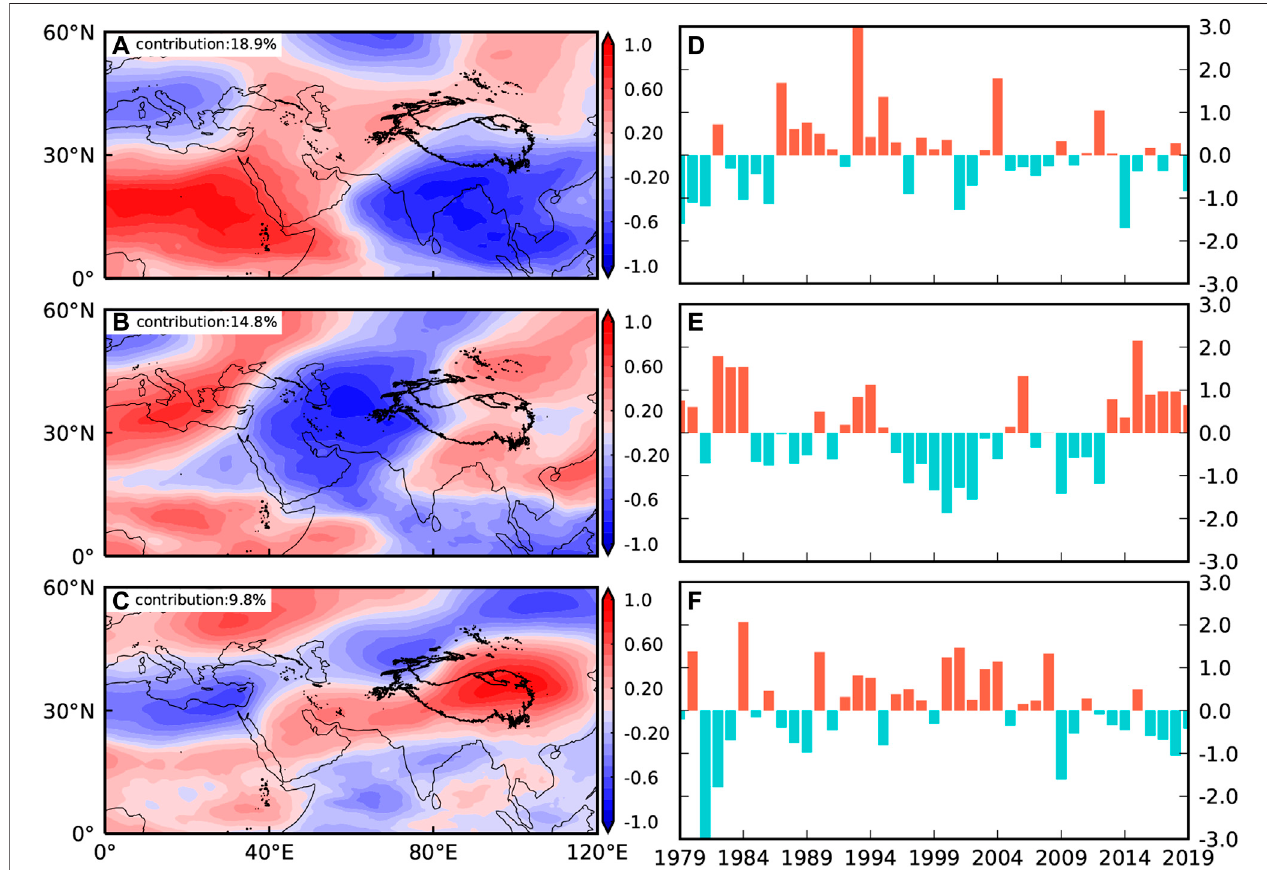
FIGURE 2 | The fi rst three EOF patterns of the TCO* from 1979 to 2019 in summer (A – C) . The EOF time series (D – F) with the red (blue) bars indicating positive (negative) values. The bold black contours denote the topography surpassing 3 km.